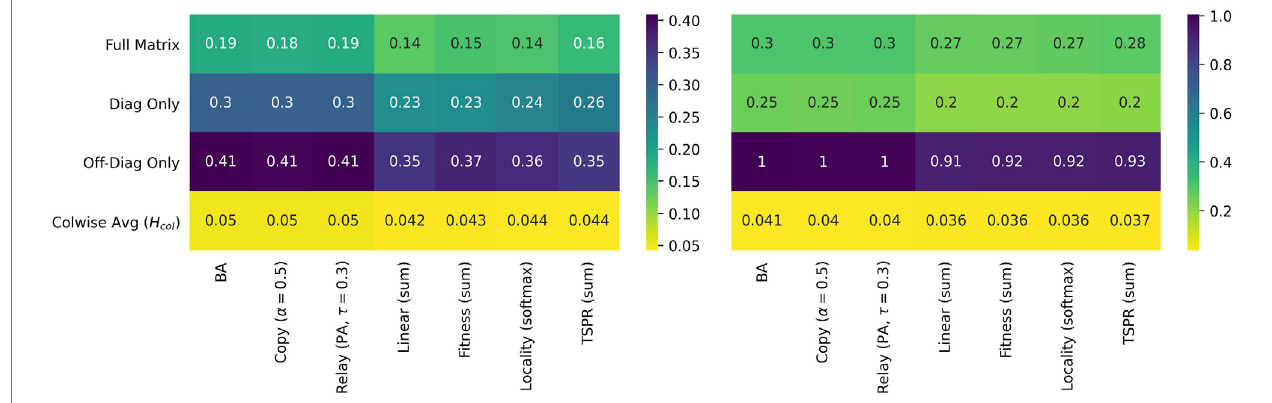
FIGURE 7 | L1 distances for USSC-calibrated (left) and SGCA-calibrated models (right) relative to their respective benchmarks. Distances in the top three rows are computed from H norm while the column-wise average L1 is computed from H col (though for L1 distances computing this from H norm yields the same result).